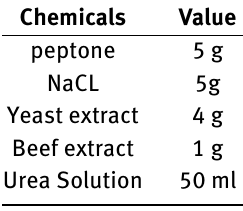
Table 1: Physical Properties of soil